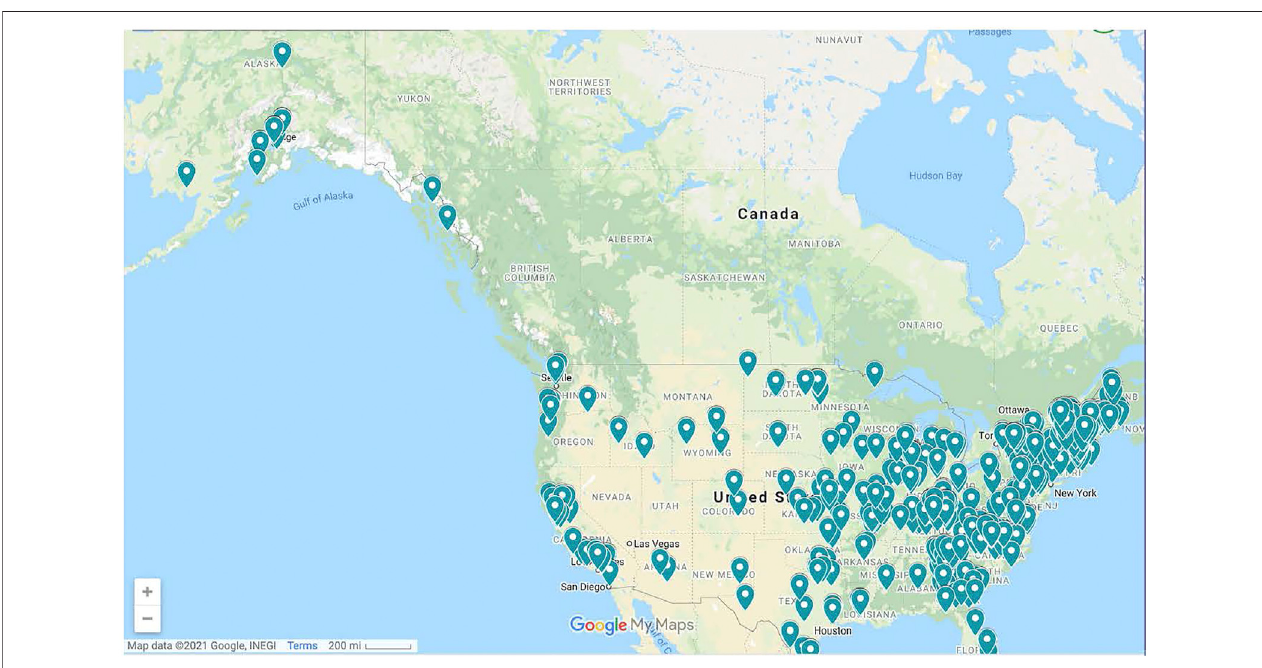
FIGURE 2 | Geographic spread of ACRES educators.